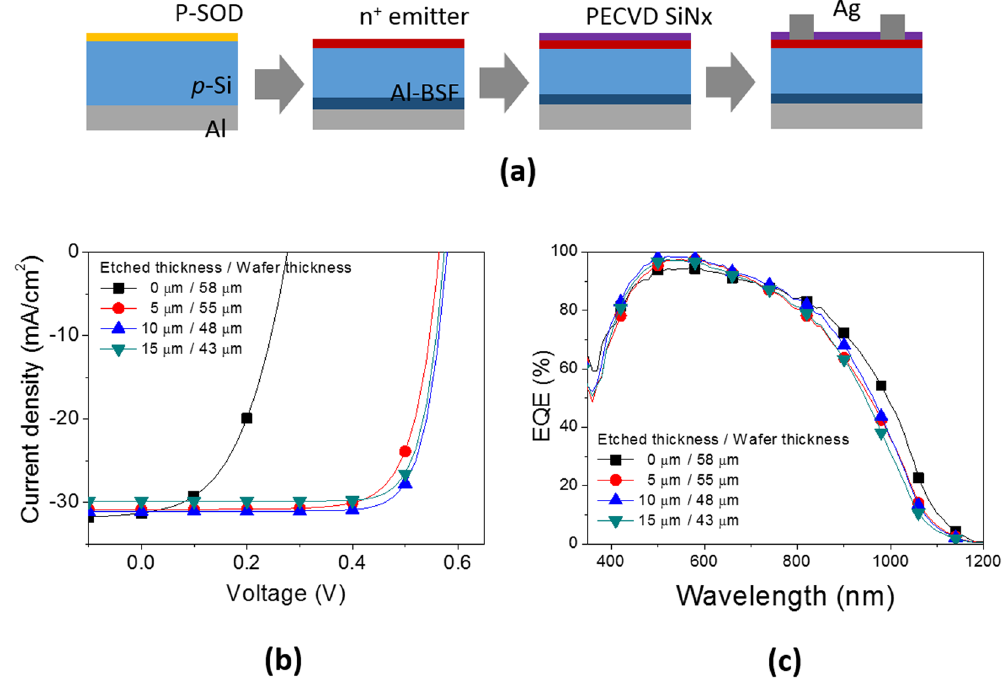
Figure 4. ( a ) Fabrication flow of solar cells based on kerfless planar-wafers without texturing. A standard device architecture with Al back surface field (Al-BSF) is adopted. ( b ) Current-voltage characteristics and ( c ) EQE spectra of the solar cells based on the kerfless wafers which were thinned by chemical etching for implantation damage removal.